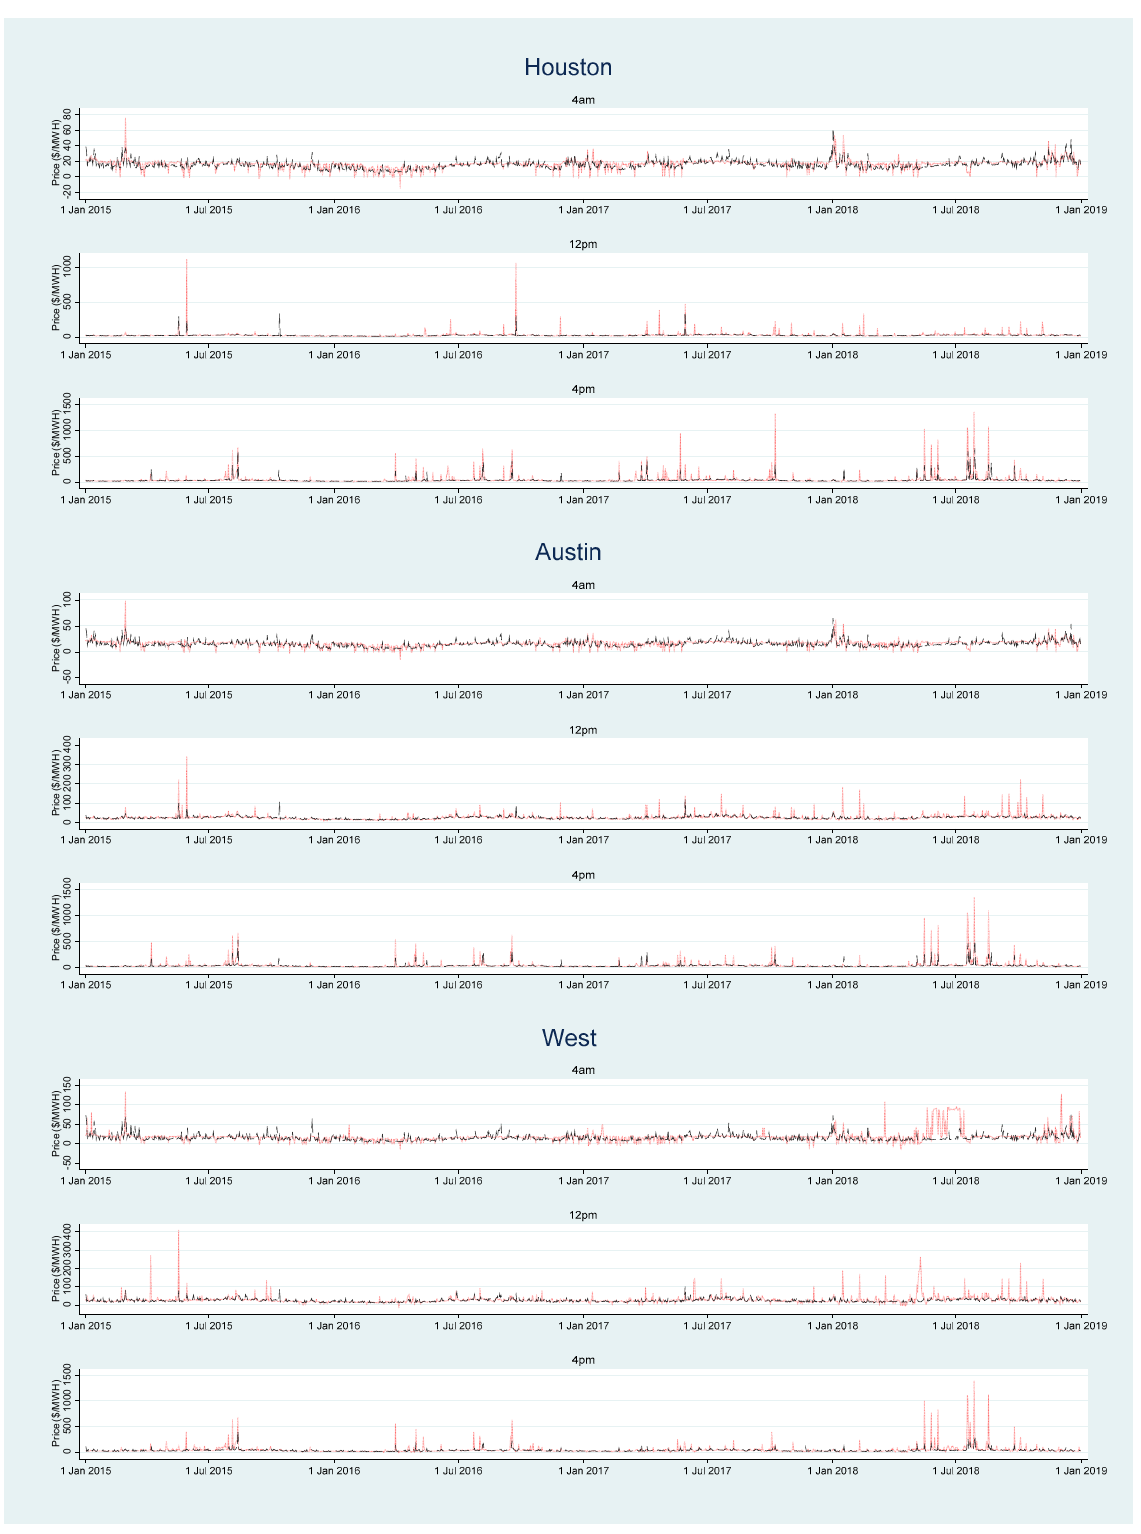
Figure 2. Time-series plots of the actual prices (solid red line) and model predicted prices (dash grey line) in Houston, Austin, and the West for the hours 4:00 a.m., 12:00 p.m. and 4:00 p.m.